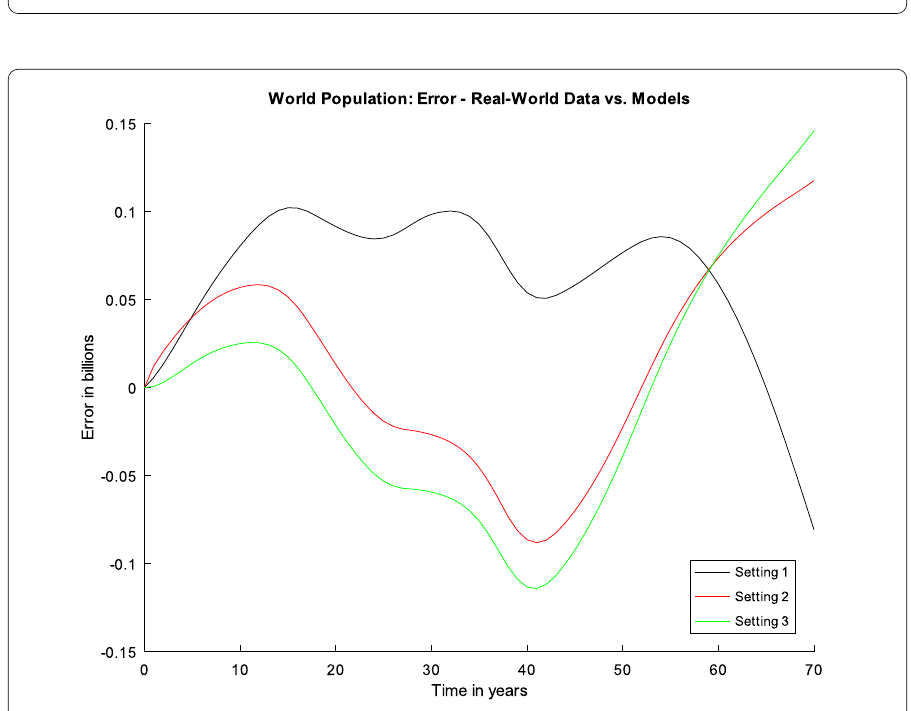
Figure 7 Results for all three settings of total world population size. Here t = 0 corresponds to the year 1950, and t = 69 corresponds to the year 2019. This is the time frame for our data